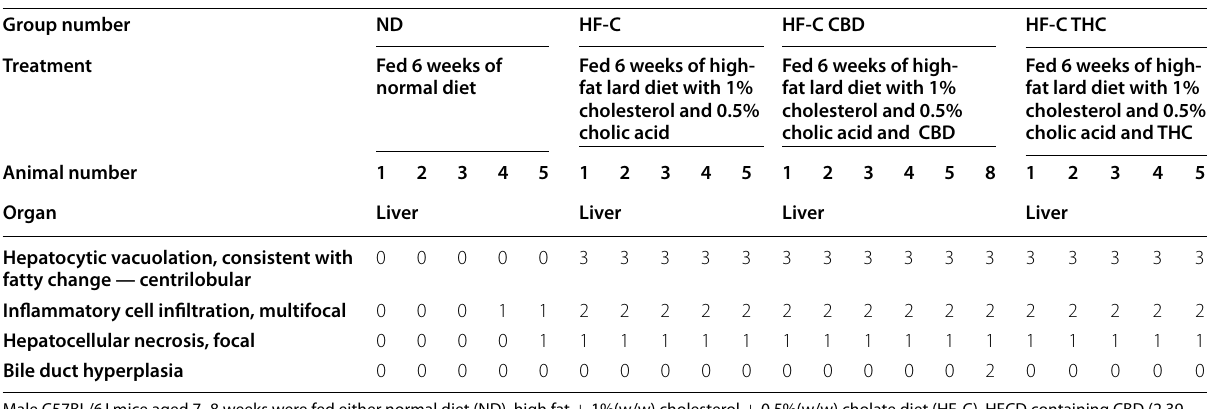
Table 4 Effect of THC or CBD treatment on lipid and enzyme profile in mice fed HFCD